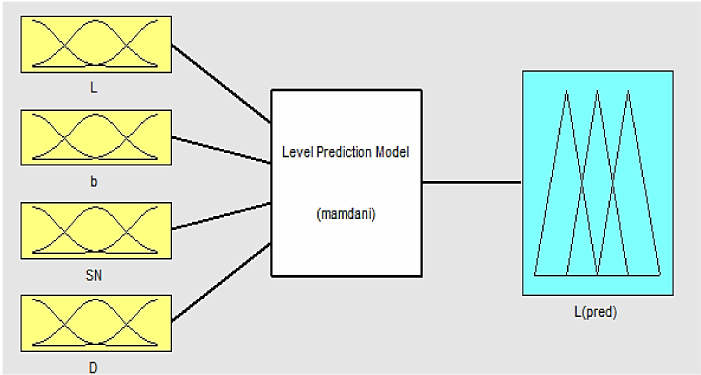
Figure A1. Structure of the fuzzy logic-based model in MATLAB.